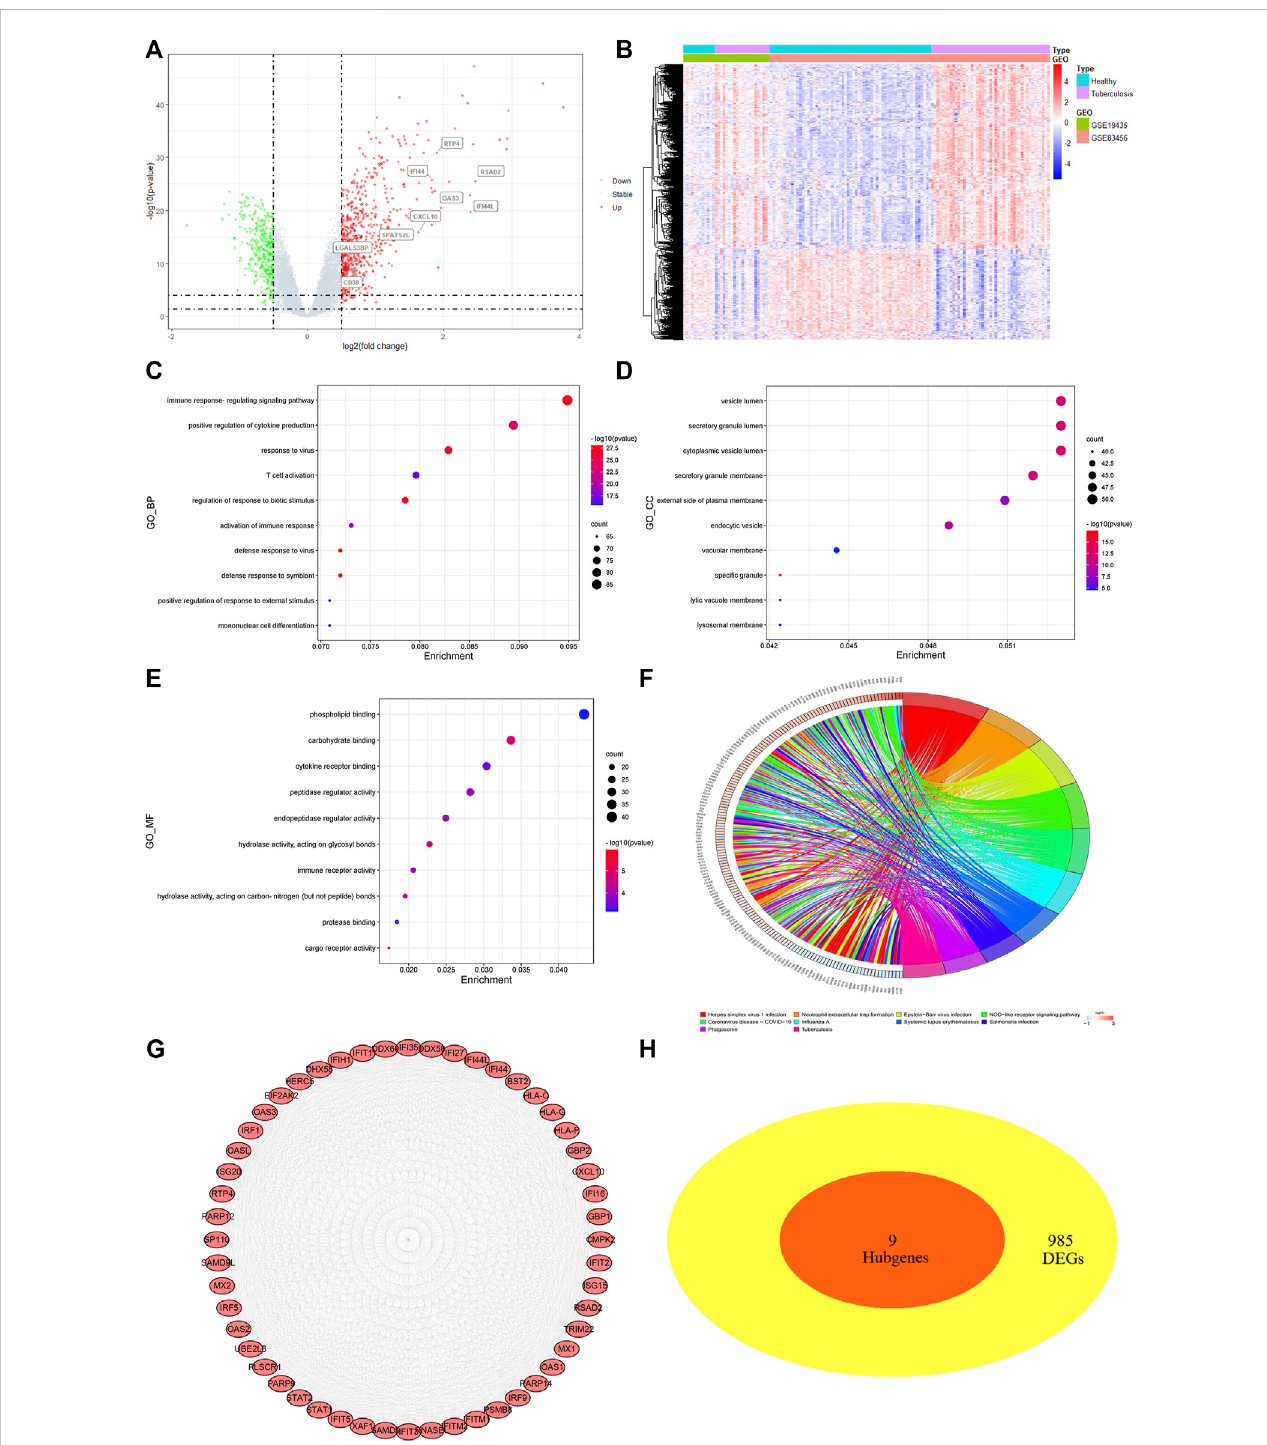
FIGURE 4 Differentially expressed genes (DEGs) screening and analysis in TB cases (A) Volcano plot presenting DEGs between TB patients and healthy individual. Red spot stood for 666 signi fi cant upregulated genes and green stood for 328 downregulated genes [FDR < 0.05 and |log FC| ≥ 0.5]. (B) Heatmap of 994 DEGs fi ltered out via “ limma ” R package. In two dataset (GSE19435 and GSE83456), samples and genes were respectively sorted by columns and rows. Blue and purple squares comprised healthy and TB group, respectively. (C – E) Top 10 GO-BP, CC, MF items of DEGs. (F) Top 10 KEGG pathway of DEGs. (G) The top module extracted from PPI, red nodes stood for upregulated DEGs. (H) VENN diagram selected common genes between hub genes and DEGs that were described as candidate key